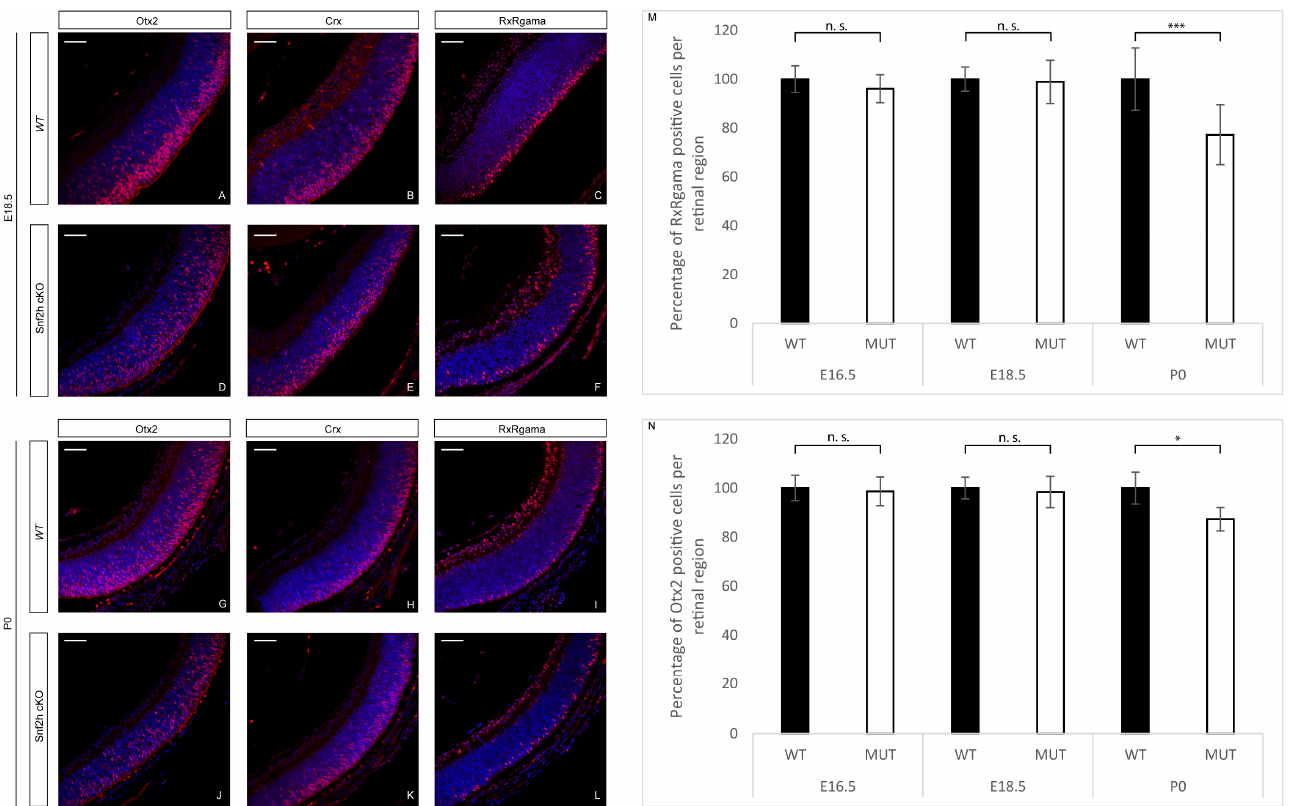
Figure 3. Photoreceptor speci fi cation in Snf2h cKO. To screen the photoreceptor development, a variety of di ff erent photoreceptor-speci fi c markers were used; among them, Otx2, Crx, and Rxr γ were chosen for the embryonic immuno fl uorescent analysis. The immunostained retinal sections showed no signi fi cant di ff erences between Snf2h cKO mice and controls at E18.5 ( A – F ). However, there was a rapid decrease in Rxr γ - and Otx2-positive cells in Snf2h -de fi cient mice immediately after birth ( G – N ). Error bars indicate standard derivation; p -values were calculated using Student’s t -test ( n = 3). * p < 0.05, *** p < 0.001, n.s. = not signi fi cant. Scale bars: 50 µm.